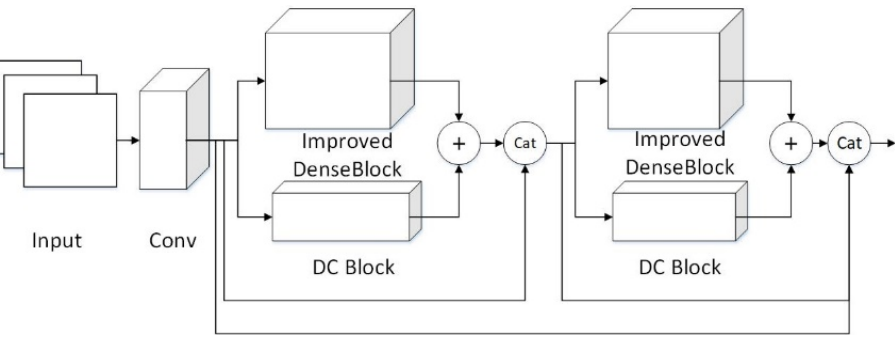
Figure 9. Dense Pyramidal Net architecture.